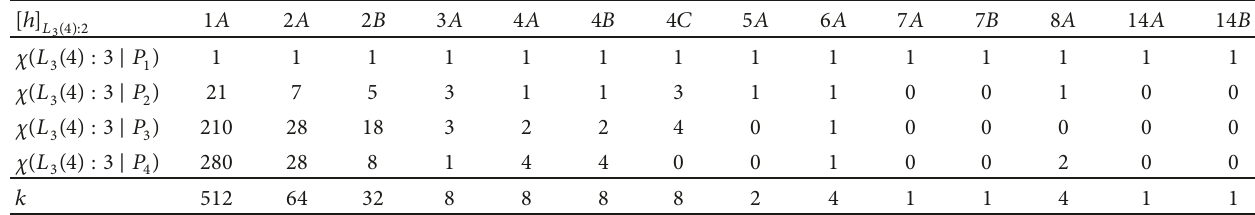
Table 1: The values of 𝜒(𝐿 3 (4) : 2 | 2 9 ) on the different classes of 𝐿 3 (4) : 2